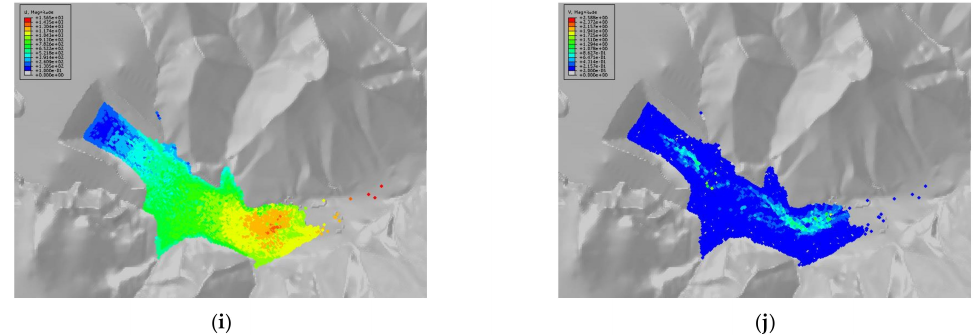
Figure 14. Process of tailing sand discharge from the breached dam. ( a ) Cloud map of tailing sand displacement distribution at 20 s. ( b ) Cloud plot of tailing sand velocity distribution at 20 s. ( c ) Cloud map of tail sand displacement distribution at 40 s. ( d ) Cloud map of tailing sand velocity distribution at 40 s. ( e ) Cloud map of tail sand displacement distribution at 60 s. ( f ) Cloud map of tailing sand velocity distribution at 60 s. ( g ) Cloud map of tail sand displacement distribution at 80 s. ( h ) Cloud plot of tailing sand velocity distribution at 80 s. ( i ) Cloud map of tail sand displacement distribution at 300 s. ( j ) Cloud plot of tailing sand velocity distribution at 300 s.